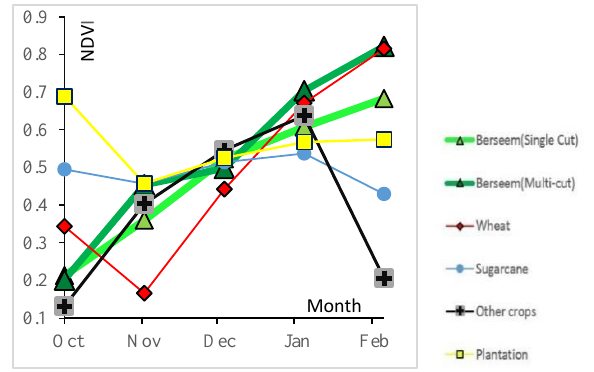
Figure 2. NDVI based temporal profiles for different vegetation